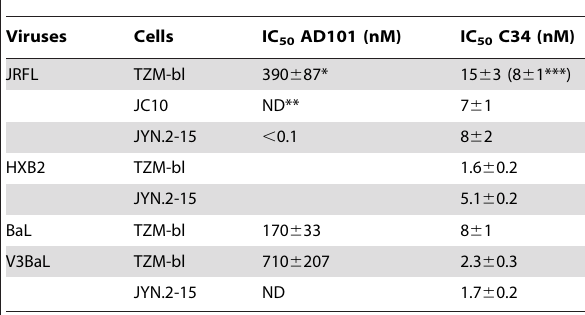
Table 1. Effective rate constants of HIV-1 fusion and inactivation.